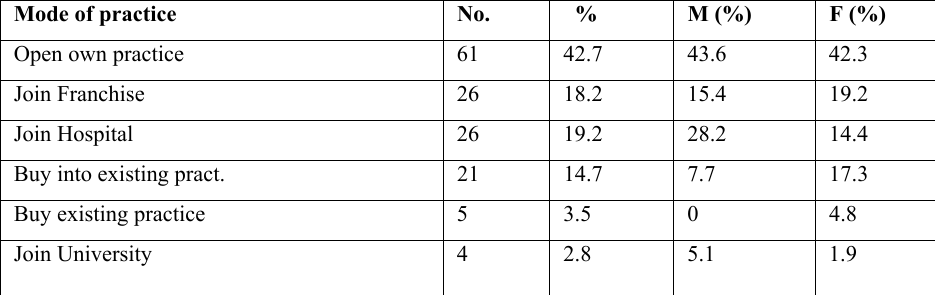
Table 8: Number and gender of respondents who felt that each of the listed modes of practice would provide the best long term financial security .